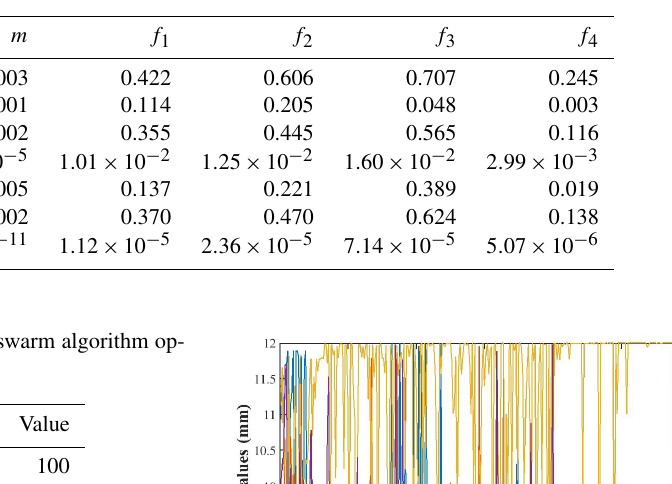
Table 5. Accuracy verification results of the Kriging agent model.